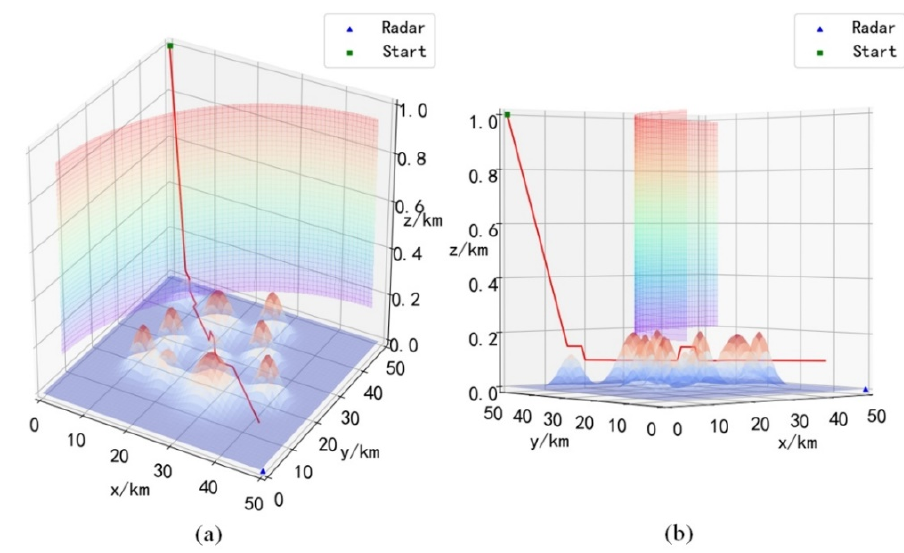
Figure 12. The path planning result in scenario 1. ( a ) is the full view of the path, ( b ) is the side view of the path.